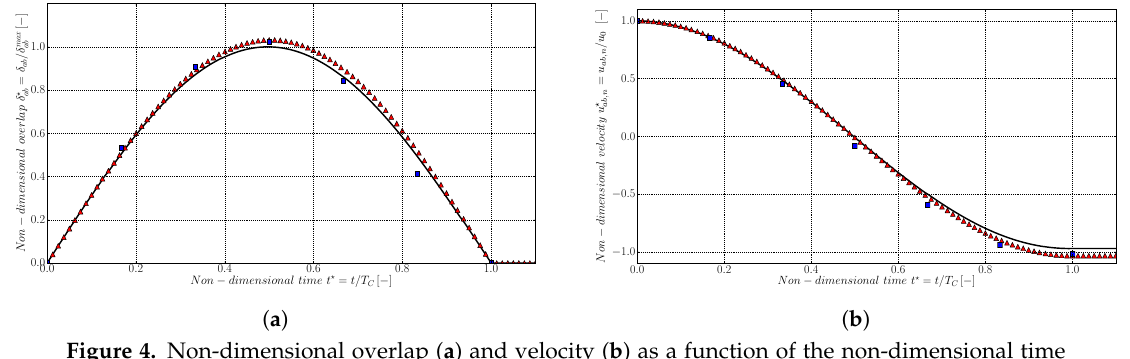
Figure 4. Non-dimensional overlap ( a ) and velocity ( b ) as a function of the non-dimensional time during the contact presented in Figure 3. Comparison between analytical method ( ), Euler method with t p = T C /80 ( ) and RK2 method with t p = T C /6 (